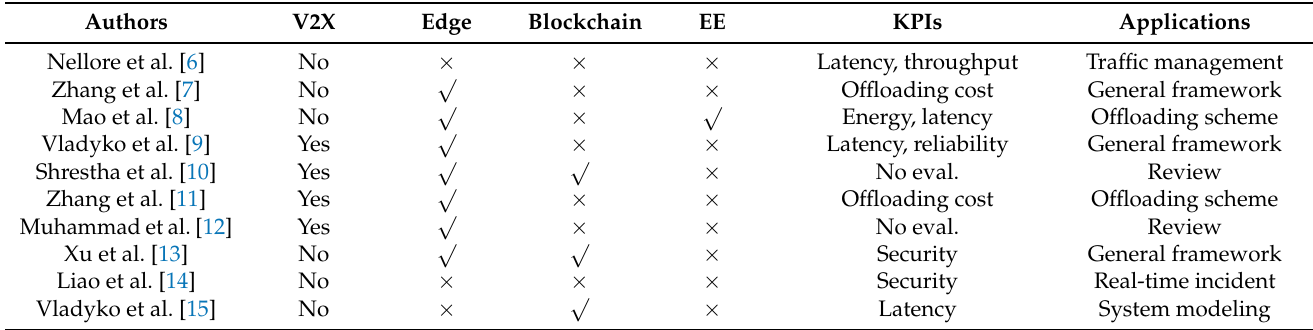
Table 1. Summery of related